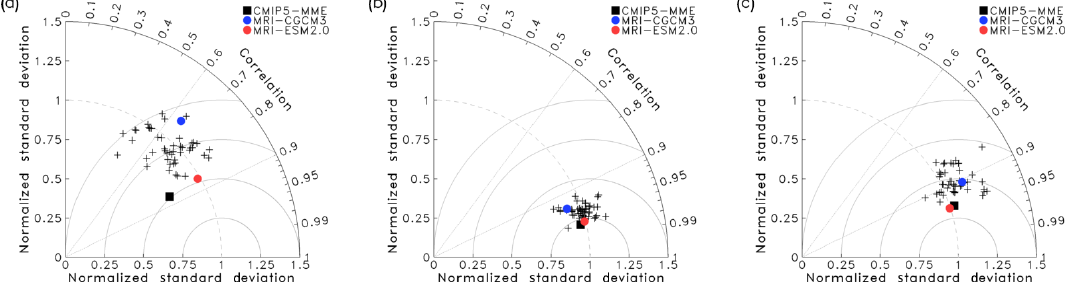
Figure 2. Taylor diagrams for upward (a) shortwave, (b) longwave and (c) net radiative fluxes at the top of the atmosphere for MRI-CGCM3 (blue dot), MRI-ESM2 (red dot), the CMIP5 multi-model mean (black square) and individual CMIP5 models (crosses). CERES-EBAF data are used as